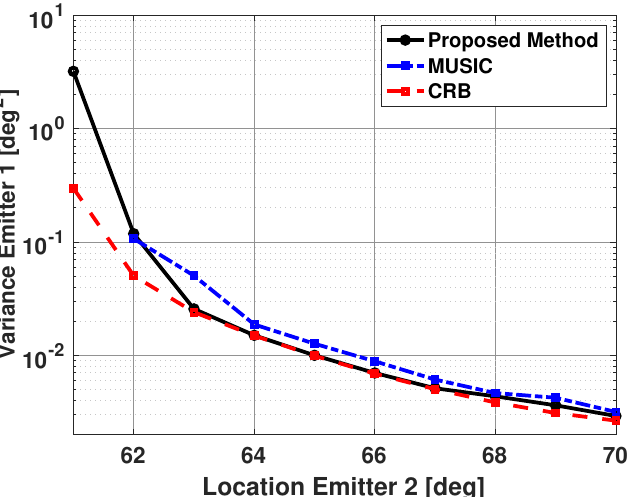
Figure 11. Variance in the estimated direction of the first emitter versus angular separation: Proposed Method and the MUSIC Algorithm, SNR = 5 dB, 100 snapshots, 500 trials.